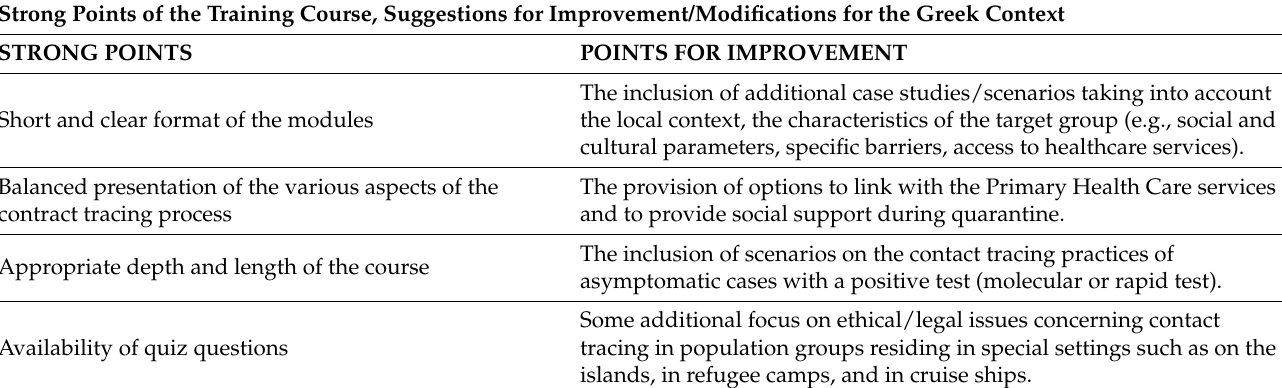
Table 1. Strong points and suggestions for the course by the